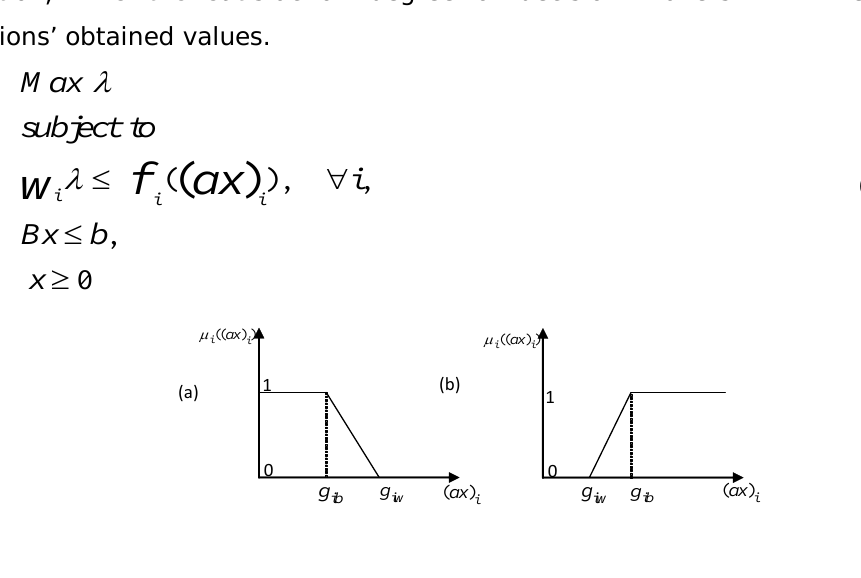
Figure 1. Linear membership functions for minimization (a) and maximization (b) objectives If the objective functions (ax) i , i=1,2,…,m , are expressed as fuzzy sets whose membership functions increase linearly from 0 to 1 (Amid et al., 2011), membership function for a minimization objective (Figure 1a) can be expressed as in Equation